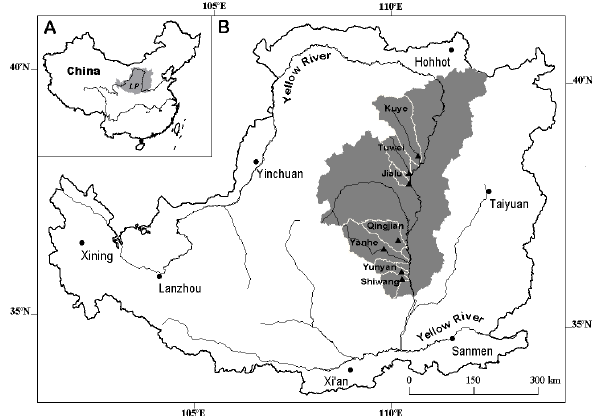
Fig. 1. (A) Location of the Loess Plateau (gray shading) in the middle reaches of the Yellow River, 2 Fig. 1. (A) location of the Loess Plateau (grey shading) in the mid- China. (B) location of the CSHC (gray shading) on the Loess Plateau and study catchments (marked 3 by their names and delineated by the white lines). The triangles indicate the hydrological gauge 4 dle reaches of the Yellow River, China. (B) location of the CSHC stations in the catchments. 5 (grey shading) on the Loess Plateau and study catchments (marked by their names and delineated by the white lines). The triangles in- dicate the hydrological gauge stations in the